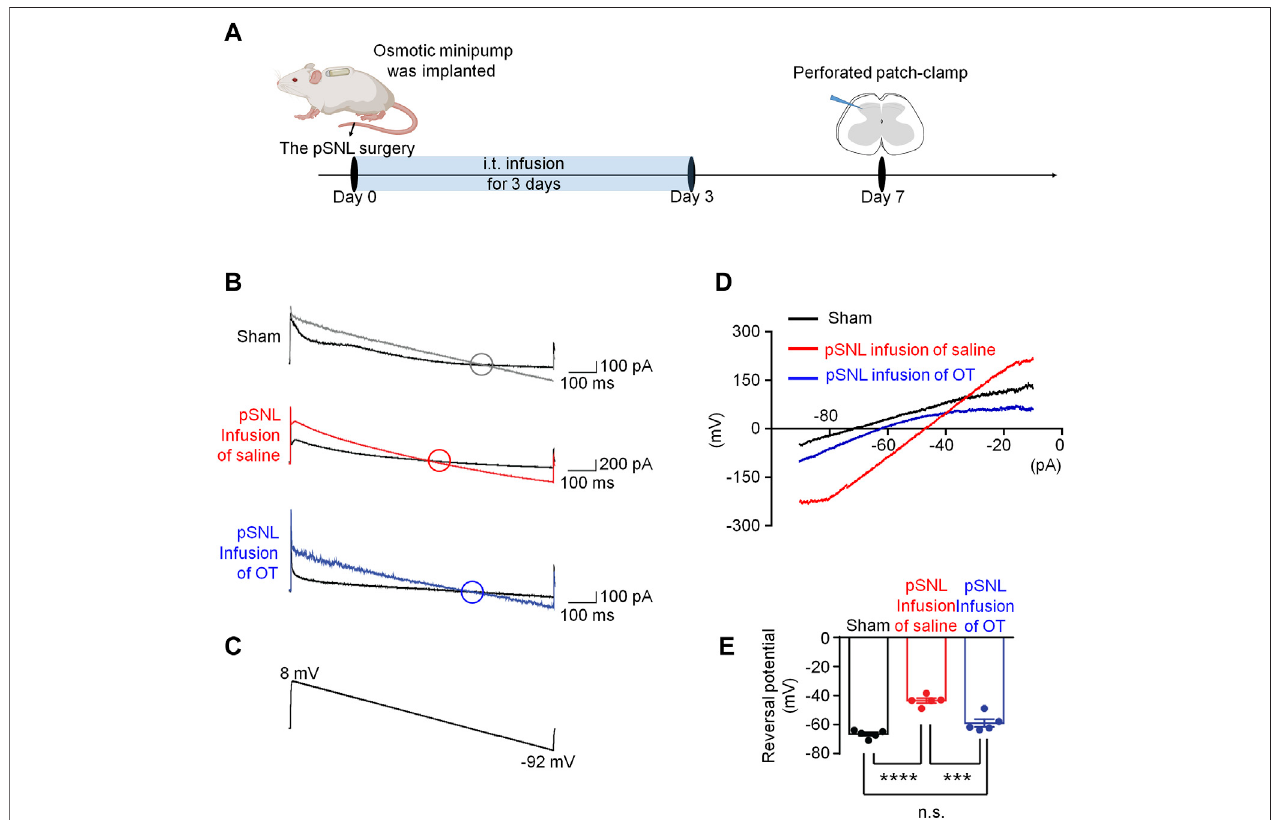
FIGURE3| Three-day continuous intrathecal OT infusion renormalized EGABA in spinal dorsal horn. (A) The schematics of the electrophysiological recording. (B,C) As voltage ramps applied from +8 to − 92 Mv (C) , basal and GABA-evoked currents were recorded (B) . (D,E) Representative (D) and statistical (E) reversal potential of E GABA recorded from slices ofsham and pSNL micetreated with continuous OTor saline. One-way ANOVA followed by Bonferroni ’ s post hoc test. Data are expressed as mean ± SEM. *** p < 0.001 sham vs. pSNL; *** p < 0.001 OT vs. saline infusion.